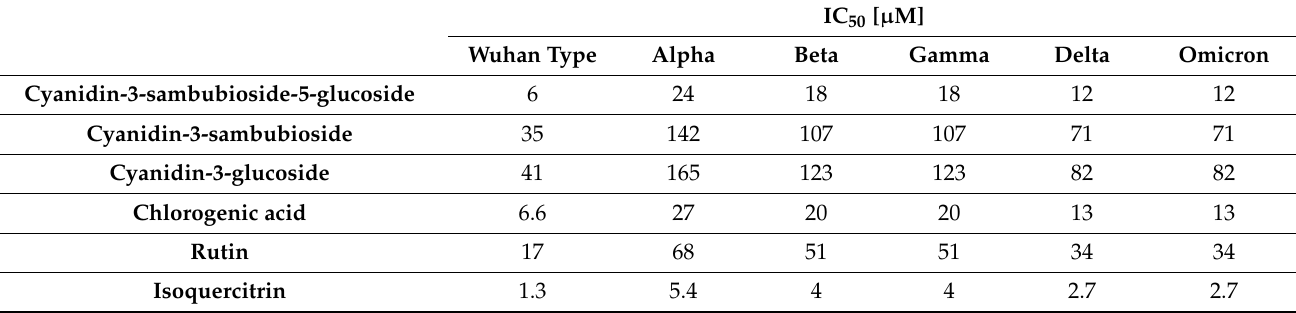
Table 3. The IC 50 values [ µ M] of the main compounds of EC 3.2 following infection of Calu-3 cells with SARS-CoV-2 Wuhan Type and